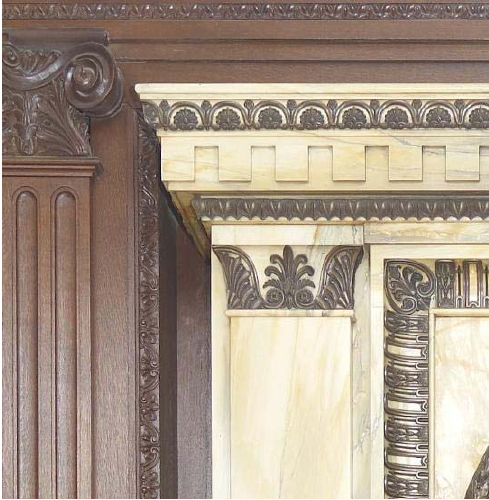
Picture 9: Distorted picture